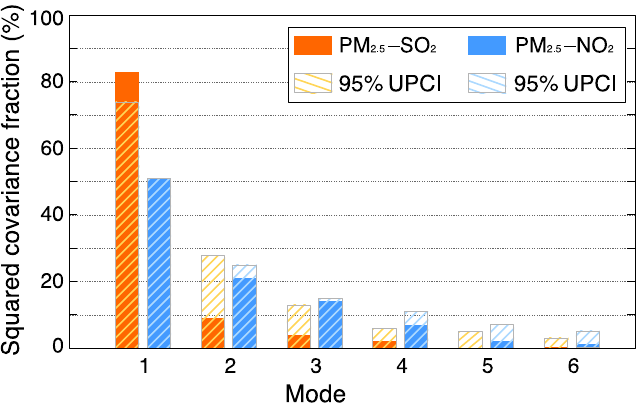
Figure 3. Squared covariance fraction for the first six maximum covariance analysis (MCA) modes between PM 2.5 and SO 2 as well as NO 2 , where 95% UPCI (upper limit of confidence interval) denotes the estimated squared covariance fraction at the 95% quantile of all values derived from the Monte Carlo simulations.